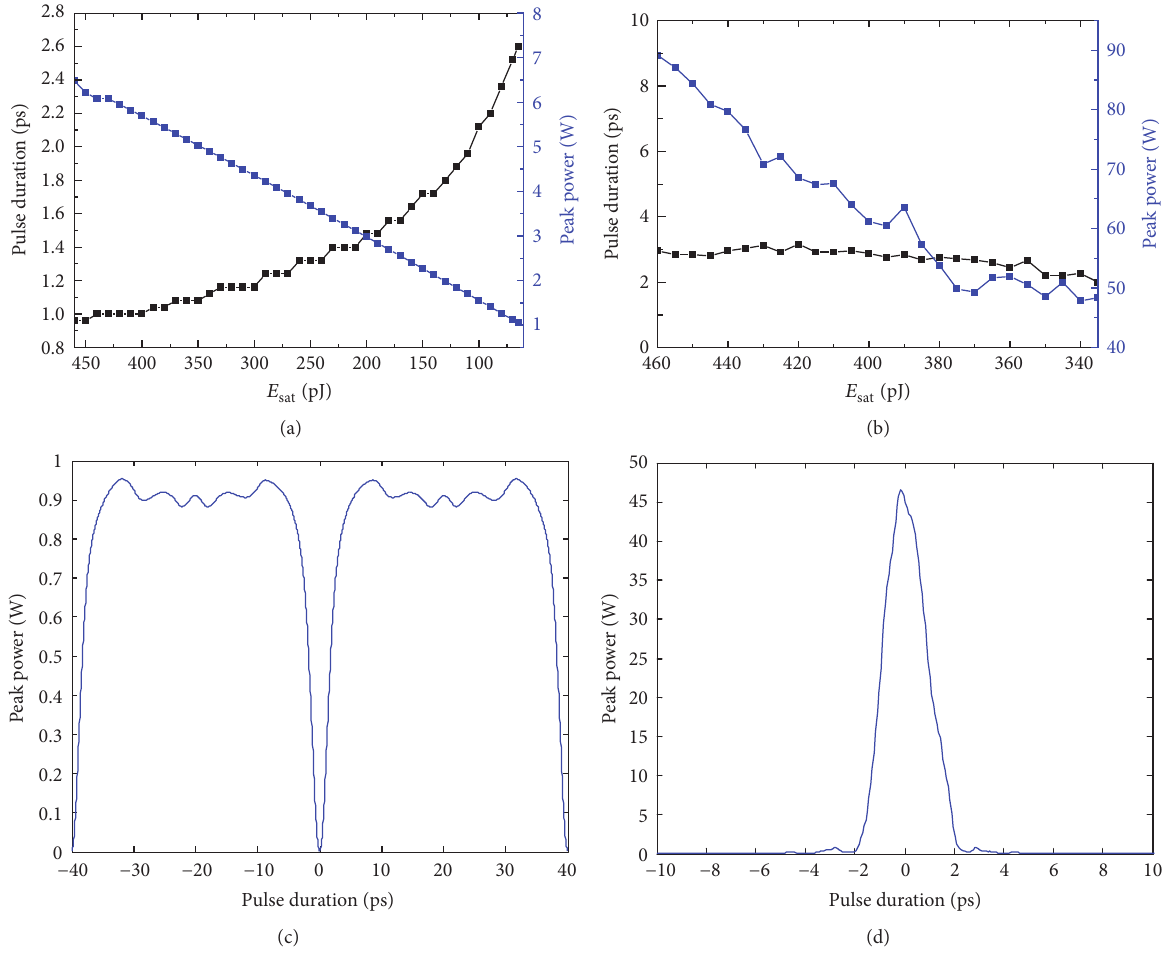
Figure 5: (a) With the decrease of 𝐸 sat , the dark soliton pulse duration and peak power change. (b) With the decrease of 𝐸 sat , the dissipative soliton pulse duration and peak power change. (c) Temporal profile of the dark soliton at 𝐸 sat = 58 pJ. (d) Temporal profile of the dissipative soliton at 𝐸 sat = 335